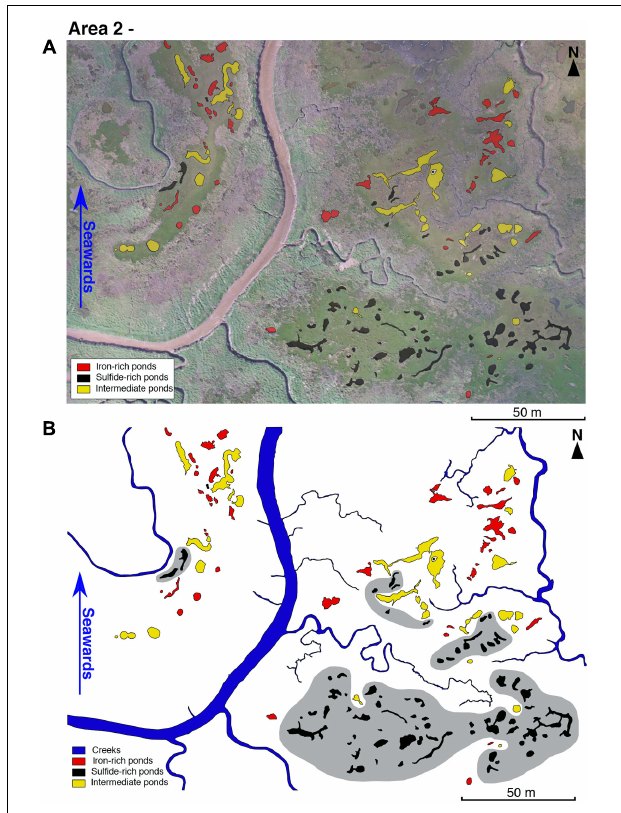
FIGURE 8 | (A) Drone imagery taken on 03/05/18 of an aggregate in Blakeney salt marsh area 2 (see Figure 1C ) overlain by geochemical classification observed over period from May 2018. (B) Geochemical classification with hypothetical, hand-drawn zones of sulfide-rich pond clustering shown in gray.